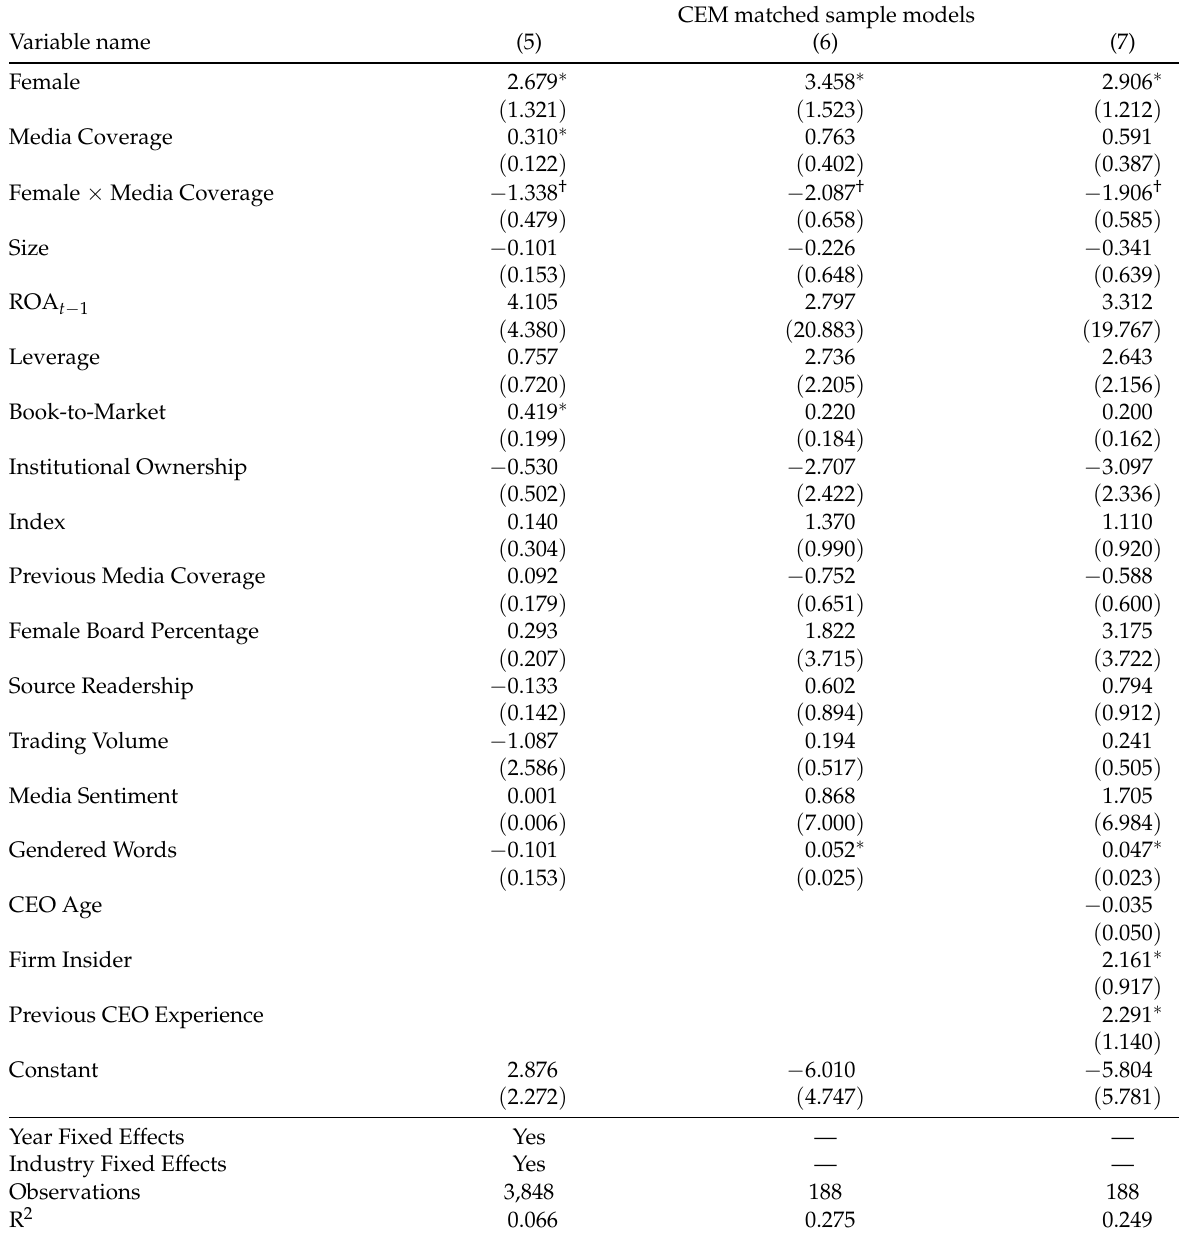
Table 5: Coarsened exact matching results of media coverage and CEO gender on cumulative abnormal